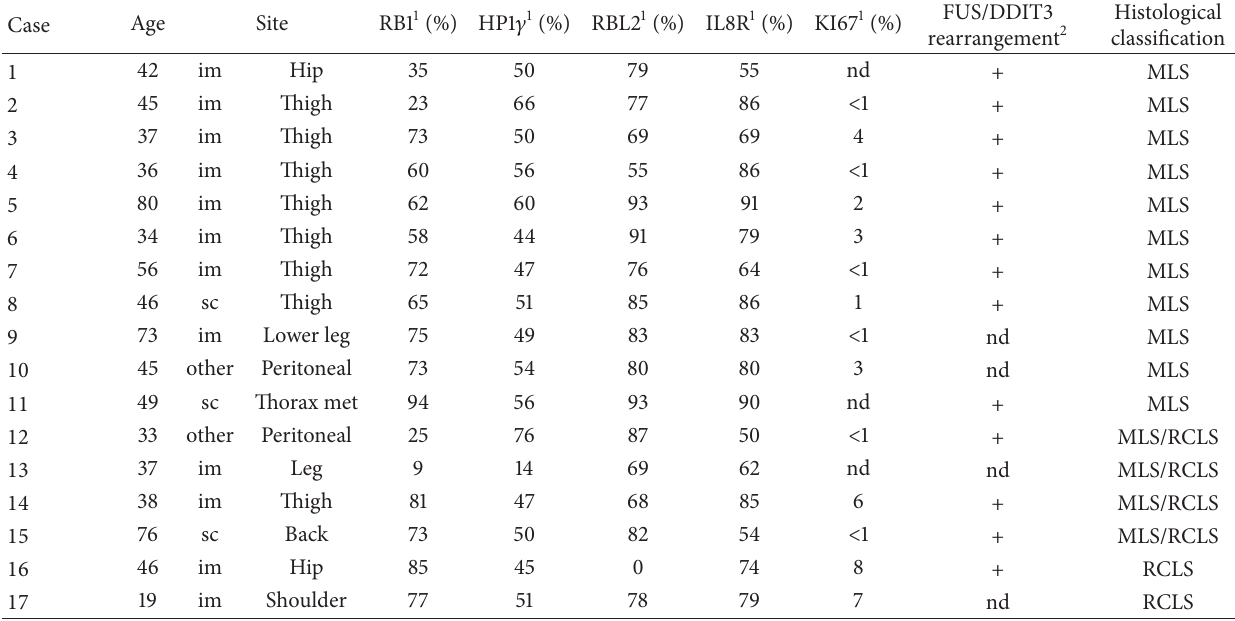
Table 1: Cases and immunohistochemistry